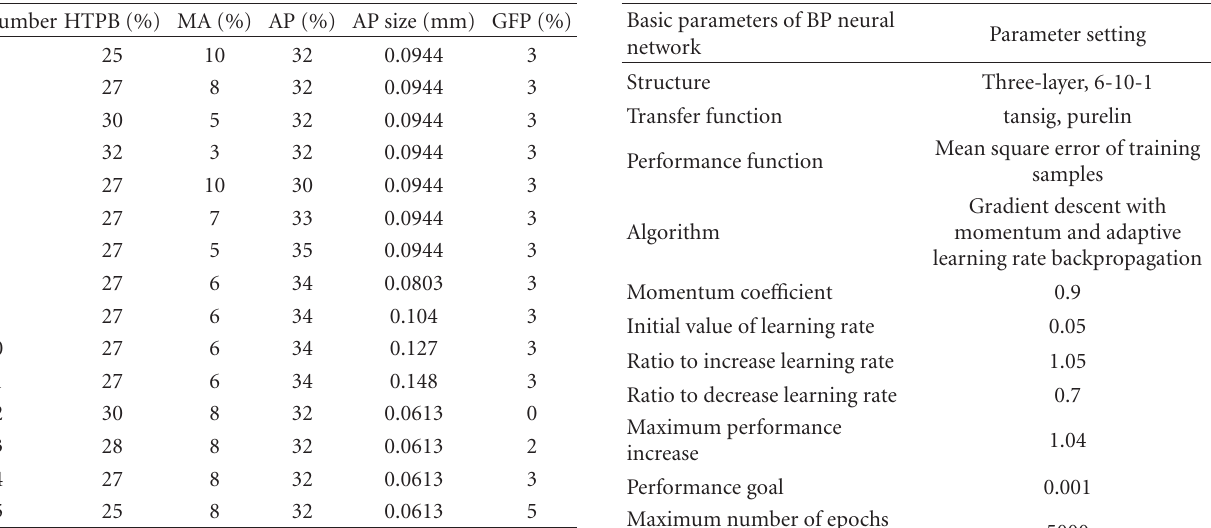
Table 1: The detailed composition of 15 formulations adopted for simulation.